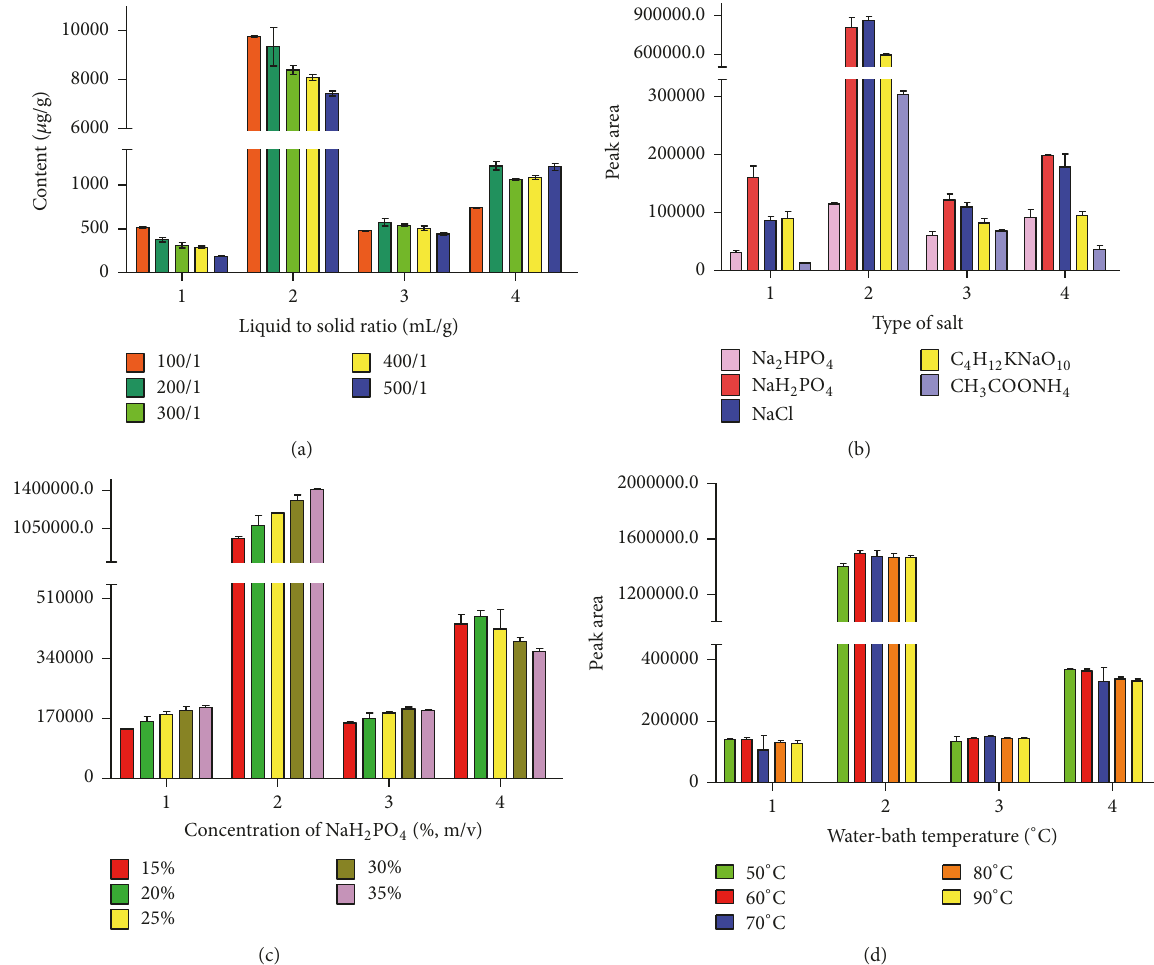
Figure 4: Effect of some parameters of cloud point extraction on the extraction effect of 4 components: (a) liquid to solid ratio (mL/g); (b) type of salt; (c) concentration of NaH2PO4 (%, m/v); (d) water-bath temperature ( ∘ C). 1, gallic acid; 2, bergenin; 3, quercitrin; 4,